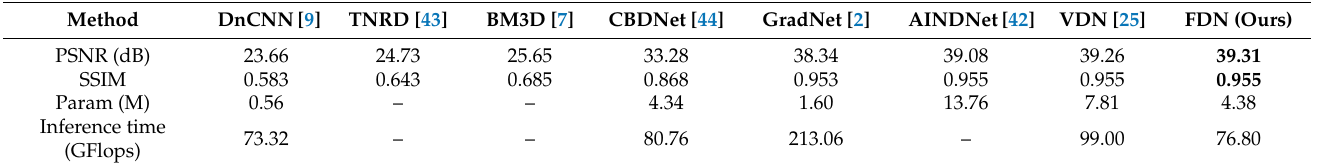
Table 3. Quantitative comparison on the real noisy SIDD dataset trained on SIDD medium